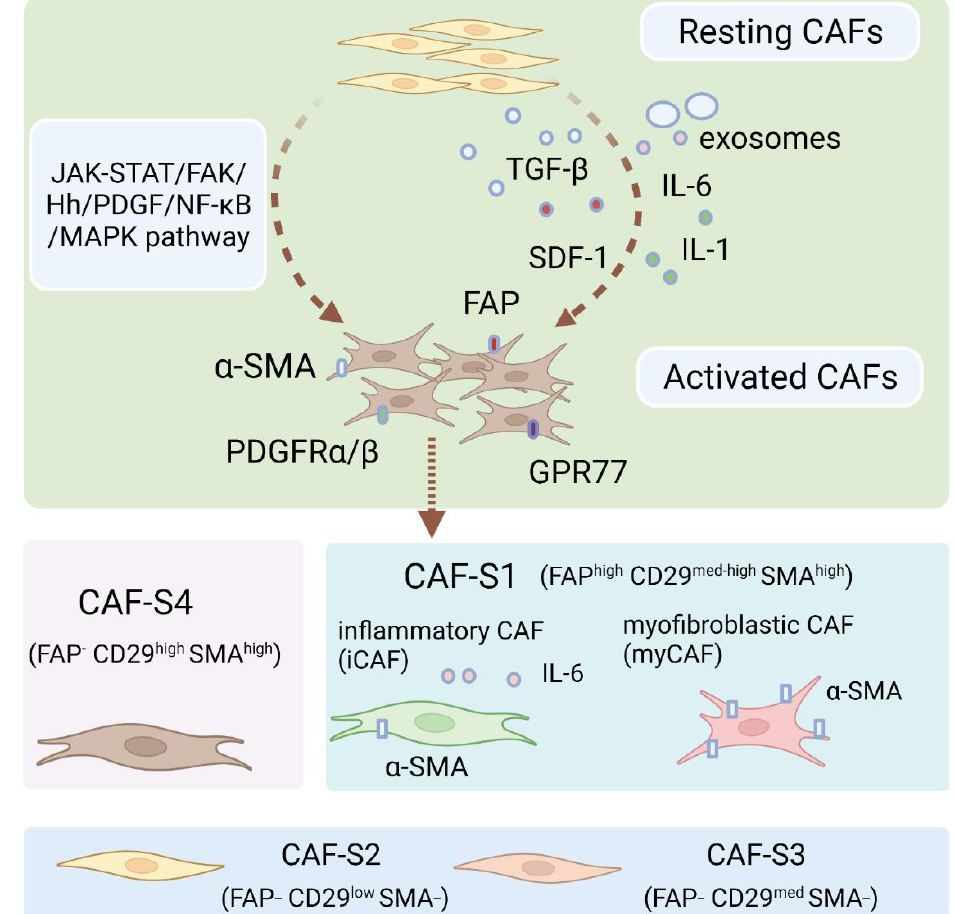
Figure 2. Pathways and mediators associated with CAFs activation. Quiescent fibroblasts can be transformed into an activated state through inflammatory cytokines and several pathways. Based on the different expressions of surface markers, including α -SMA, FAP, CD29, PDGFRβ, FSP1 , and CAV1, CAFs are classified into four subsets in some cancers. Single-cell sequencing analysis of CAF-S1 in ovarian cancer has identified two subsets, iCAFs and myCAFs. Image created with BioRender.com (accessed on 25 May 2022).